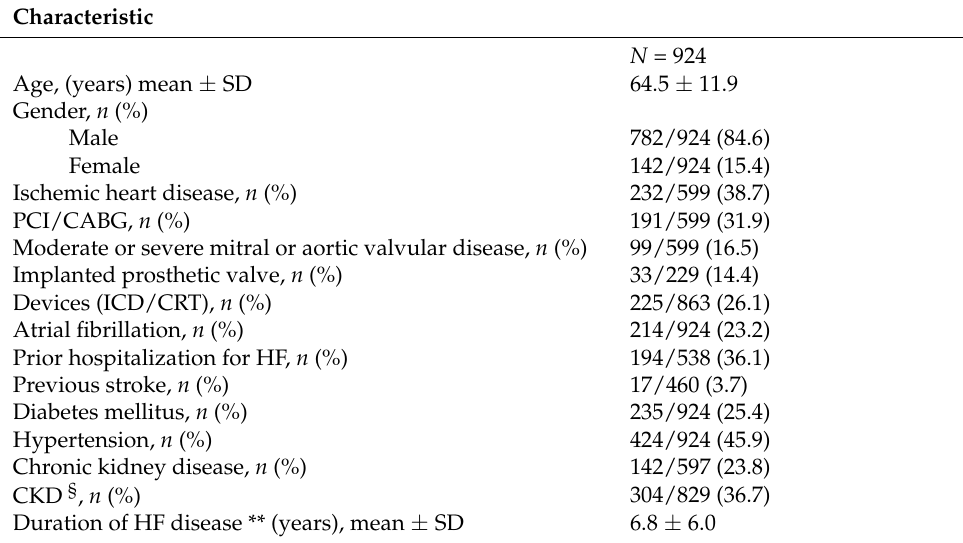
Table 1. Baseline demographic and clinical characteristics of patients treated with sacubitril/valsartan during the characterization period